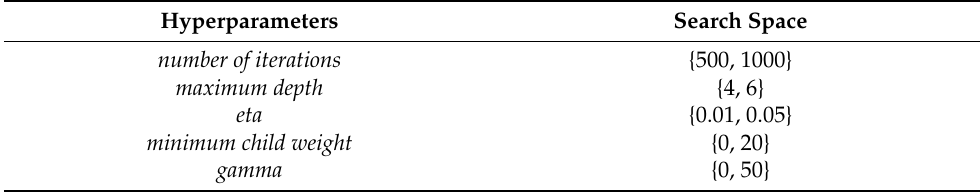
Table 4. Detailed hyperparameters